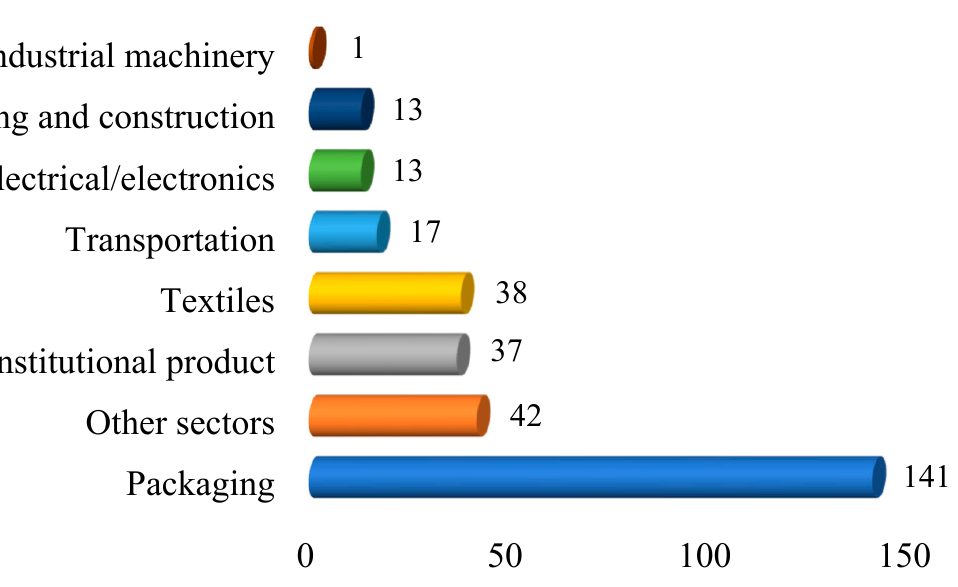
Figure 1. Plastic waste generated by different industrial sectors [2].